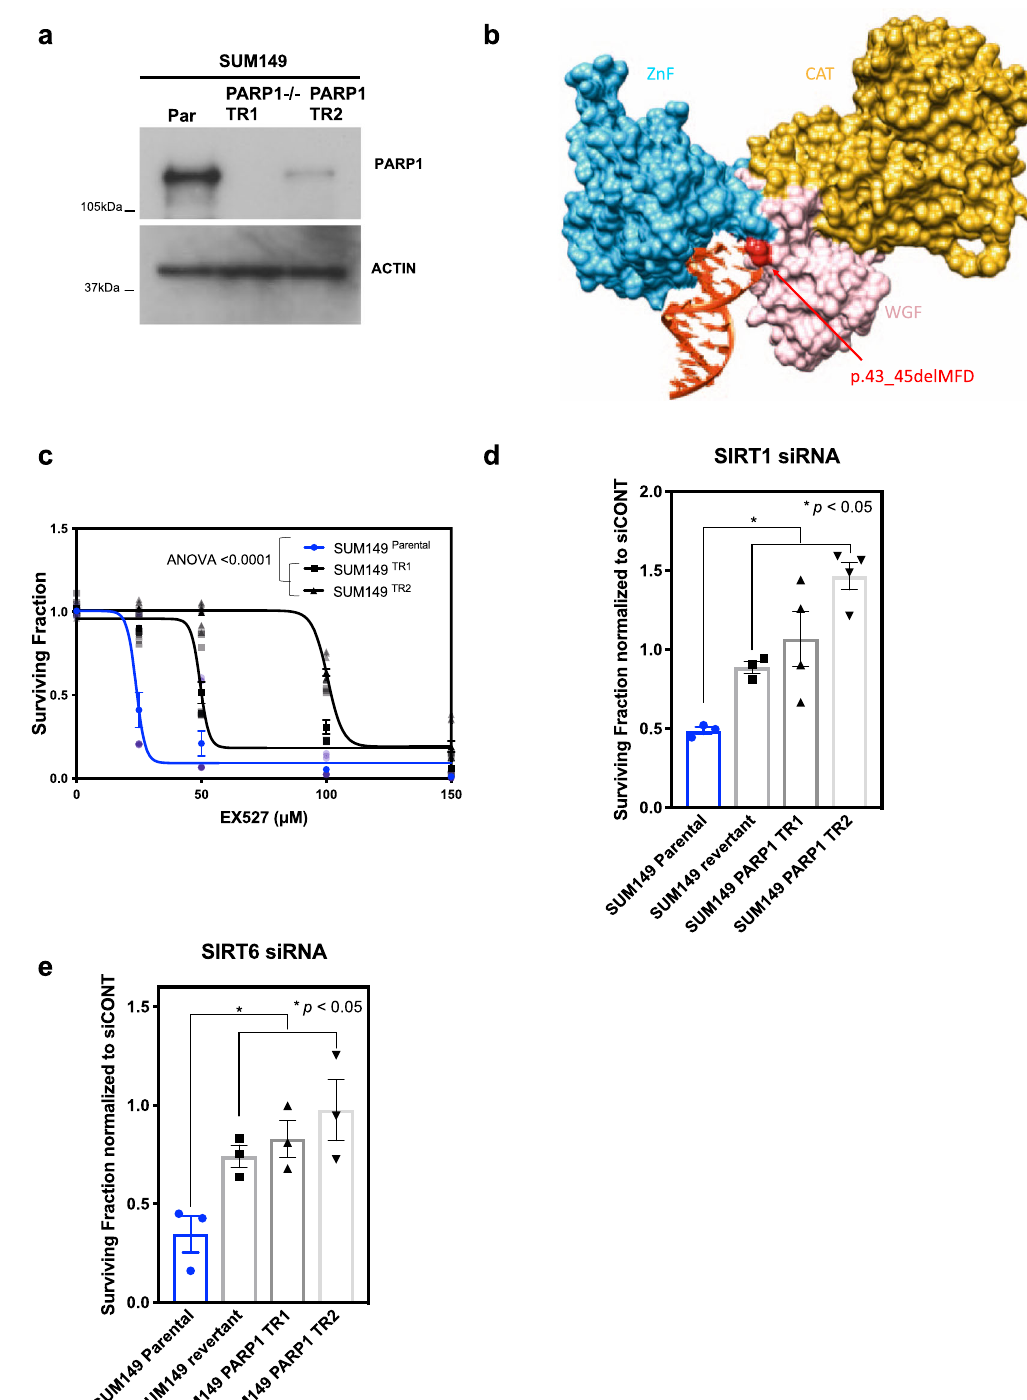
Fig. 4 SIRT/BRCA synthetic lethality mediated by SIRT1 and SIRT6 is PARP1 dependent. a Western blotting from SUM149 (parental), SUM149 PARP1 deleted (TR1) and SUM149 PARP1 ZnF mutant (TR2) cell lysates. Samples were probed with anti-PARP1 and anti-ACTIN antibodies. b Schematic representation of PARP1 TR2 mutant bound to DNA. c Isogenic SUM149 cells were exposed to increasing concentrations of SIRT inhibitor EX527, and grown for 7 days. Surviving fractions were calculated, normalised to DMSO controls, and analysed using an ANOVA with a Bonferroni correction for multiple comparisons. Error bars, SEM from n = 11 experiments. d Isogenic SUM149 cells were transfected with siRNAs targeting SIRT1. Six days post transfection, cell viability was assessed using CellTiter-Glo, and values normalised to viability following control siRNA transfection. Data presented as surviving fraction, relative to siRNA control. and analysed using a Student ’ s t-test. Error bars, SEM n = 3 for SUM149 parental and revertant and n = 4 for SUM149 TR1 and TR4 model. e Isogenic SUM149 cells were transfected with siRNAs targeting SIRT6. Six days post transfection, cell viability was assessed using CellTiter-Glo, and values normalised to viability following control siRNA transfection. Data presented as surviving fraction, relative to siRNA control, and analysed using a Student ’ s t test. Error bars, SEM from three independent experiments. Source data are provided in Supplementary Data 6.